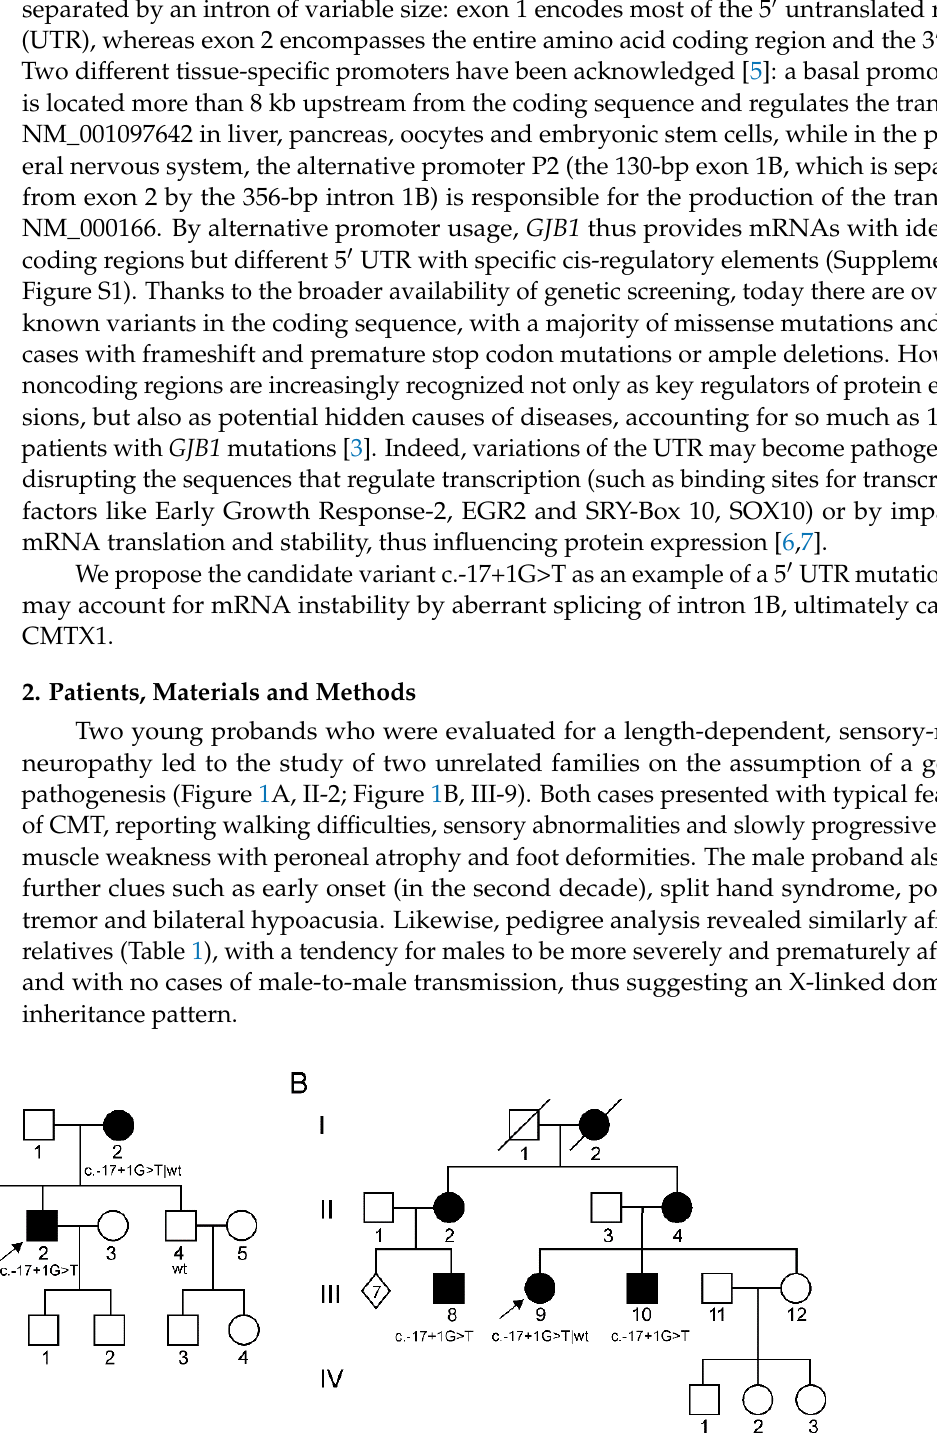
Figure 1. Pedigree tree of both families. ( A ) First family; ( B ) Second family. Arrows indicate the probands. Black circle/square: female-/male-affected individuals; open circle/square: female/male healthy individuals; wt = wild-type. LOD (logarithm of the odds) score was 2.107, assuming an X-linked dominant model of inheritance.